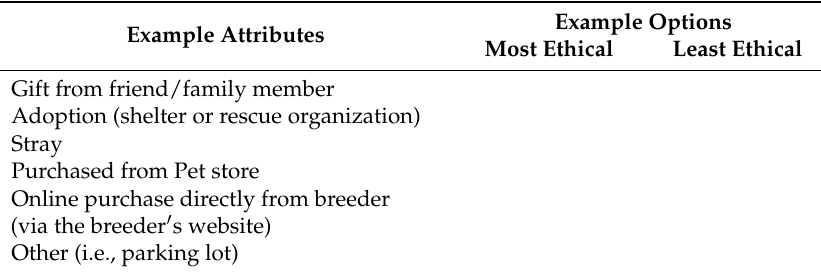
Table 1. Best-worst block